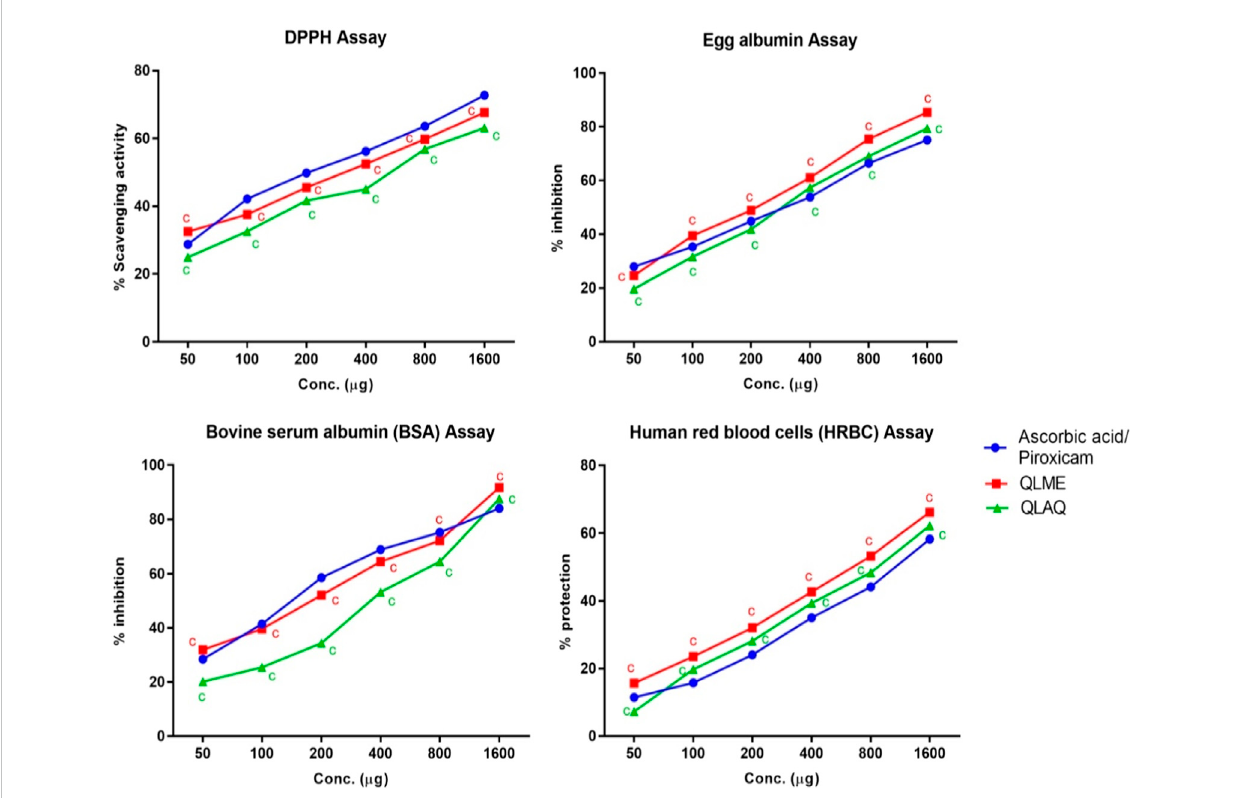
FIGURE 1 Invitro antioxidant(DPPHassay)and invitro anti-in fl ammatory(proteindenaturationandHRBCmembranestabilizationassays)activitiesof Quercus leucotrichophora extracts. Results presented as mean ± S.D (n = 3). ‘ c ’ ( p < 0.0001) in contrast to standard control. QLME: Q. leucotrichophora methanolic extracts ; QLAQ: Q. leucotrichophora aqueous